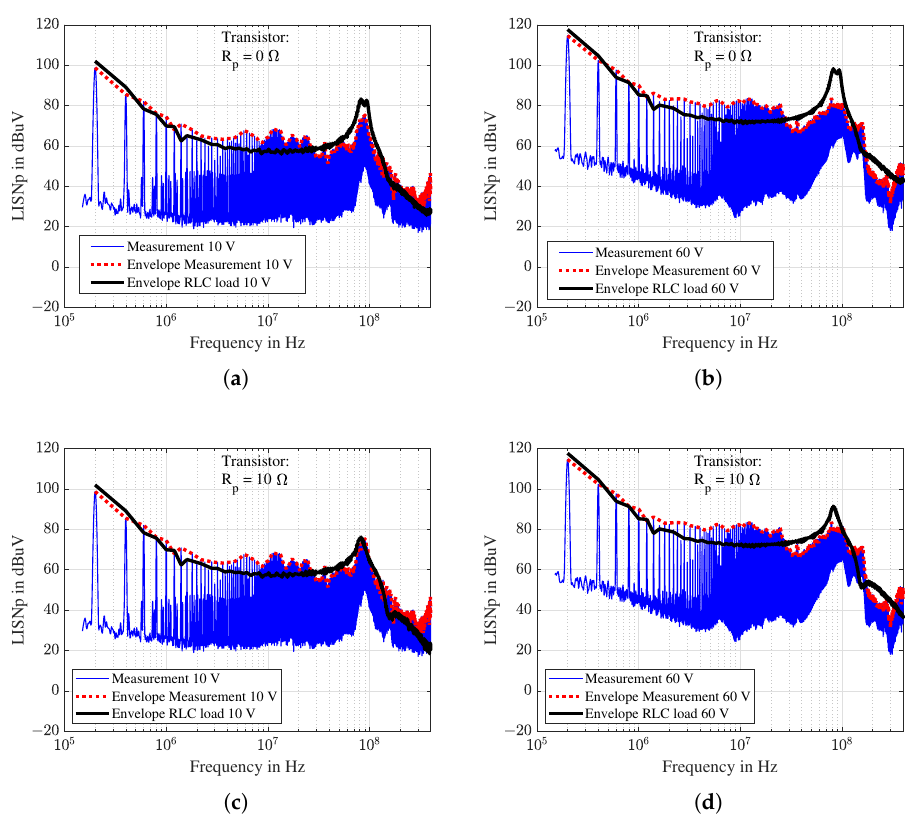
Figure 25. Comparison between measured and simulated conducted emissions with V DC = 10 V and V DC = 60 V. ( a , b ) Simplified RLC load model and R p = 0 Ω . ( c , d ) Simplified RLC load model and R p = 10 Ω